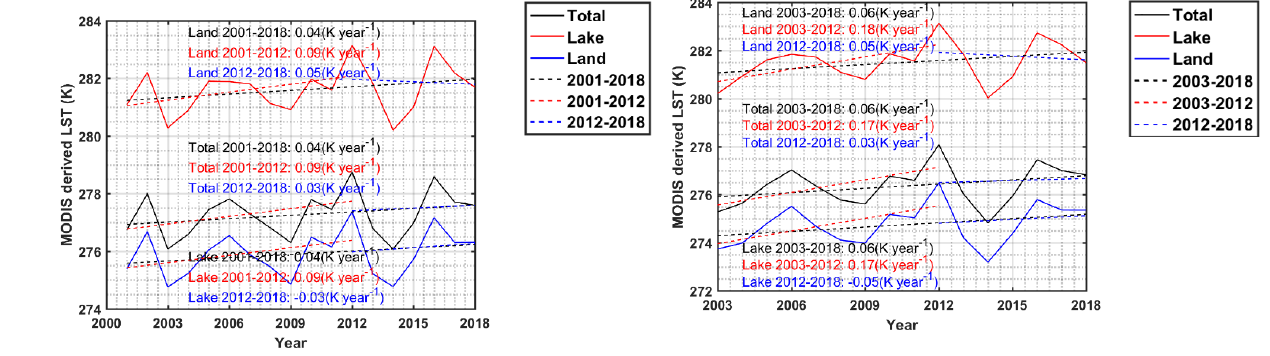
Figure 4. Total study area’s annual trend (K year −1 ) from MOD11A2 ( a ) and MYD11A2 ( b ) nighttime LST for different time periods. The HydroLAKES database (http://wp.geog.mcgill.ca/hydrolab/, May 1, 2021) was used to differentiate lake and land. The dotted lines are the linear regression lines for different time periods including 2001/2003−2018, 2003−2012 and 2012−2018.